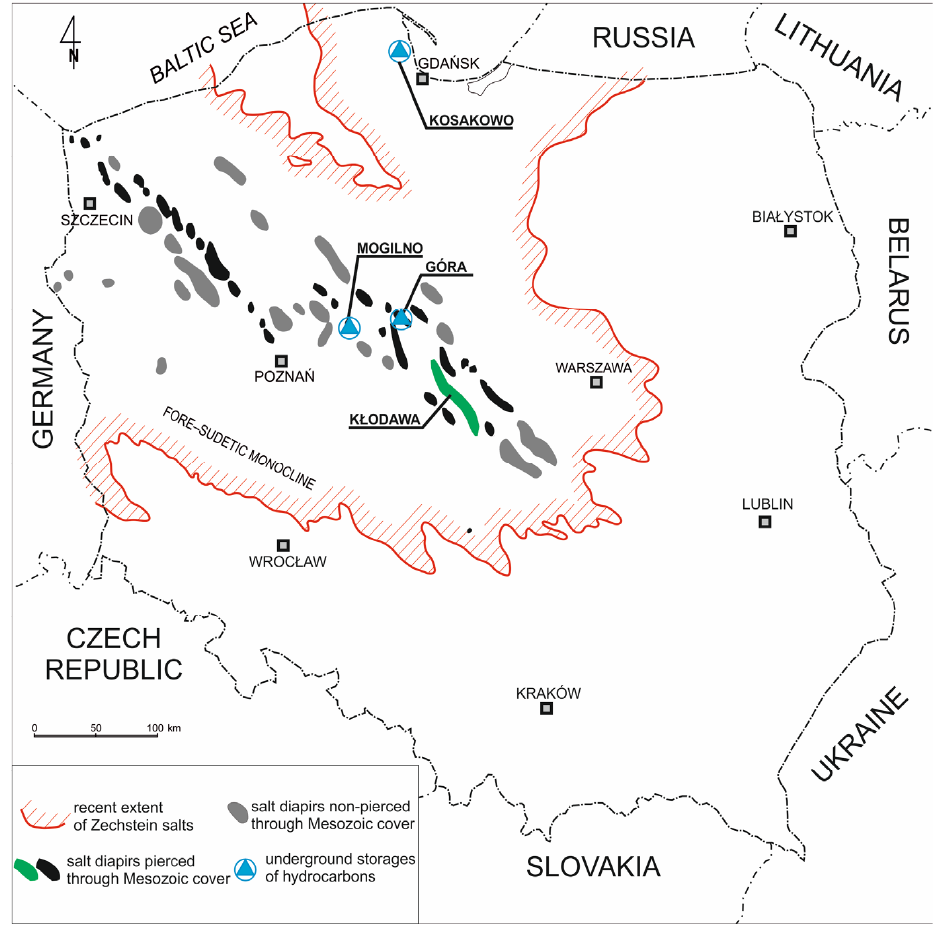
Figure 1. Location of underground hydrocarbon storages and Kłodawa salt mine at the map of salt diapirs in Poland [1,3].